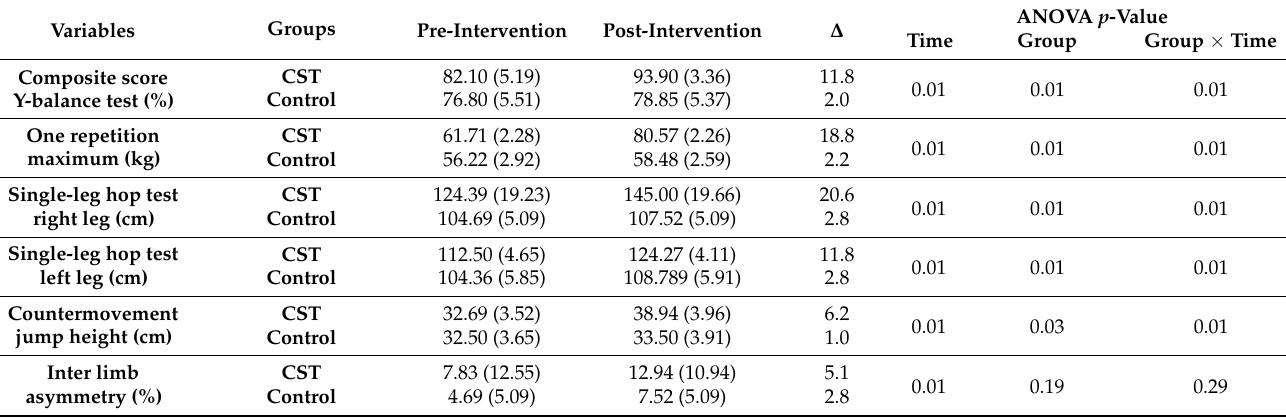
Table 2. Effects of contrast strength training on measures of athletic performance in